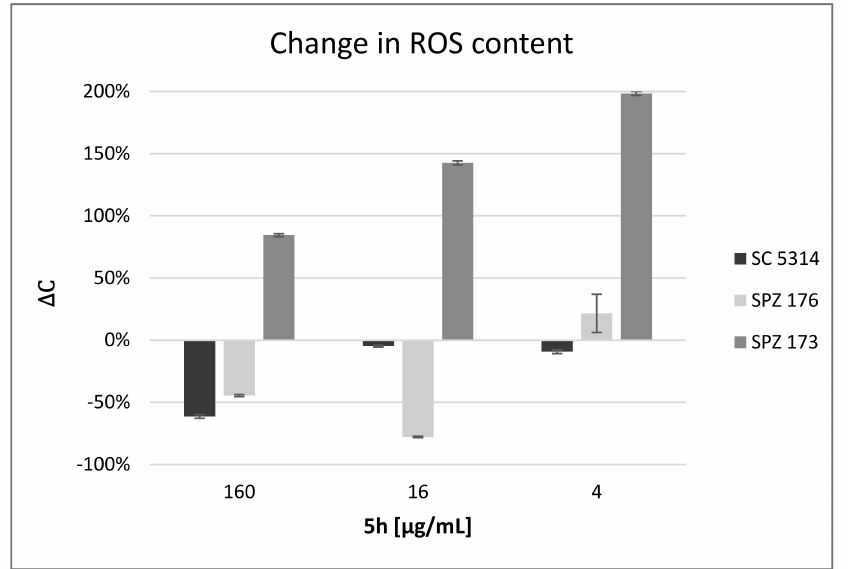
Figure 2. Change in ROS content in fungal strains treated with 5h . Legend: ∆ C = [E(Test) − E(Control)] × 100%/E(Control); where ∆ C − change in the ROS content; E(Test) − fluorescence of test samples; E(Control) − fluorescence of negative control [29,30]. C. albicans SC5314, C. albicans SPZ176 and C. neoformans SPZ173 treated with 5h compared to the untreated control. Values are presented as means ± relative standard deviation. Data represent mean ± SD, n =